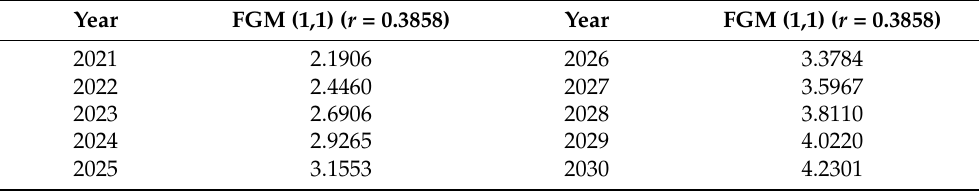
Table 4. The prediction results of China’s annual solar power share in 2021–2030